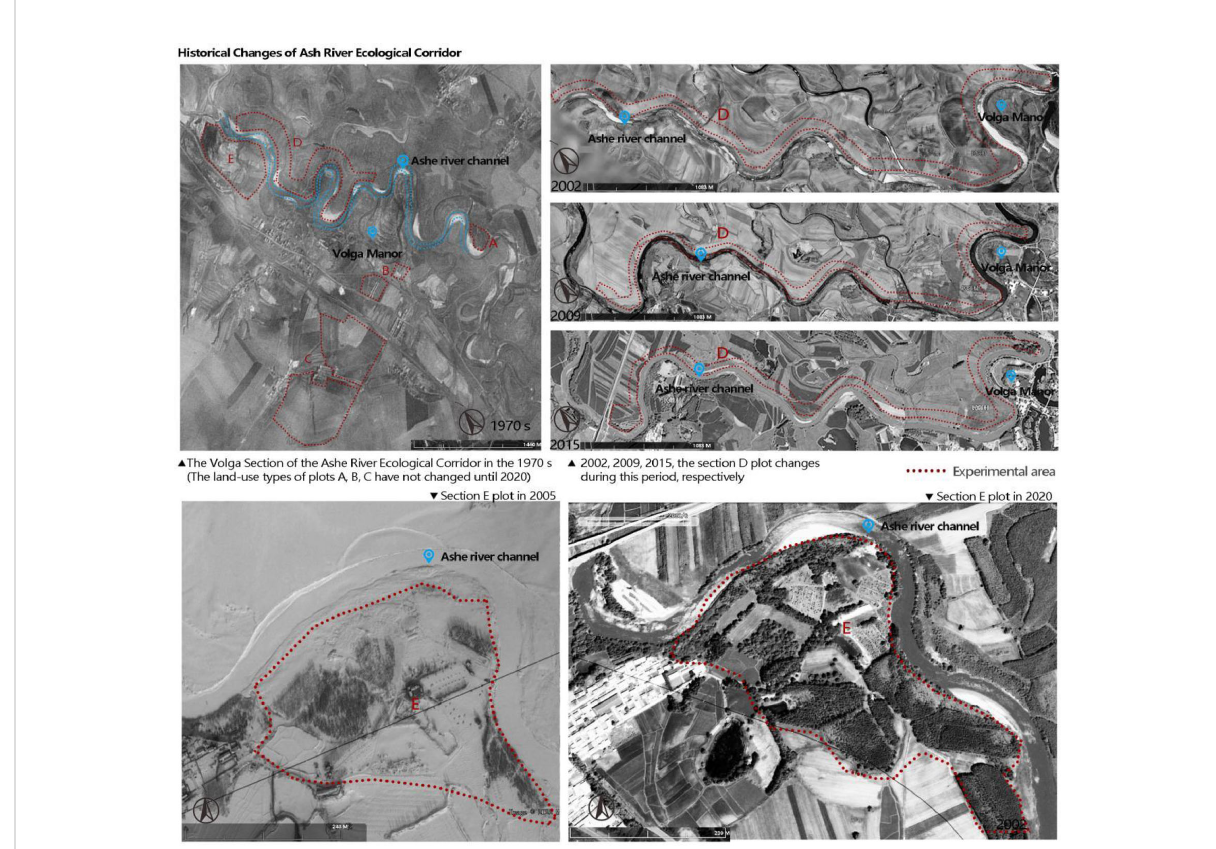
FIGURE 2 The number of years of recovery for all samples studied was based on local maps, historical archives, aerial photographs, and fi eld surveys. (Photographs from USGS and CNES/AIRBUS) The small characters in the above picture show the location and shooting date of each picture sampling